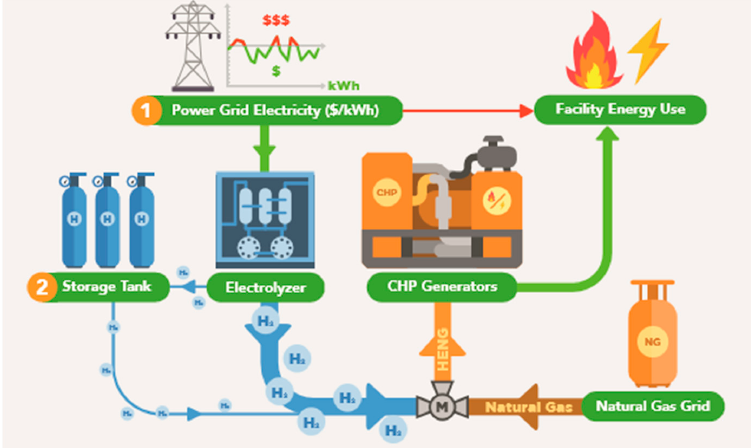
Figure 1. Simplified schematic of the industrial manufacturer’s energy system including applicable hydrogen technologies.